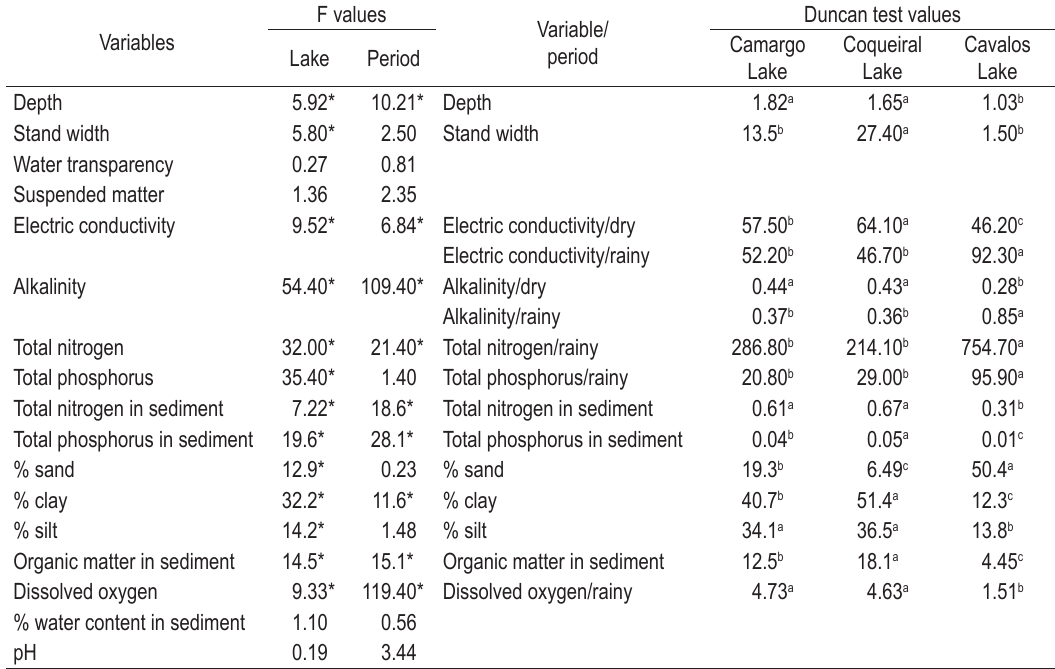
Table 1. ANOVA F values in the abiotic factors comparison between lakes and periods, and Ducan test of means parameters (values followed by the same letter are not significantly different; *p < 0.05 for F values).